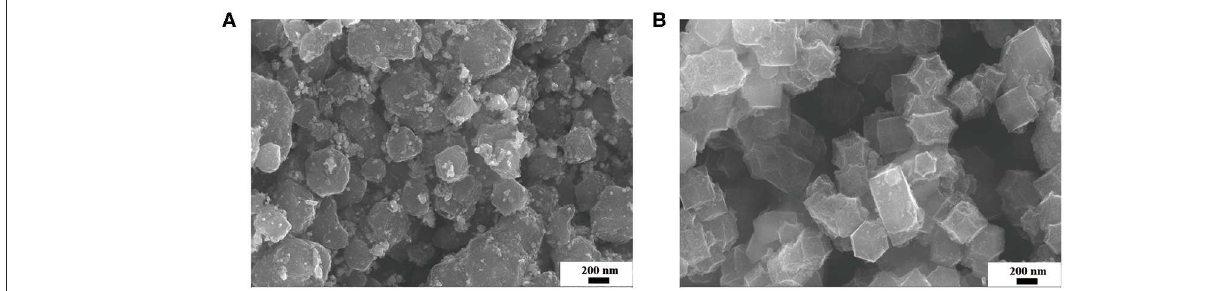
FIGURE 1 | SEM images of (A) the S-Co-N/C-I, and (B) S-Co-N/C-II.